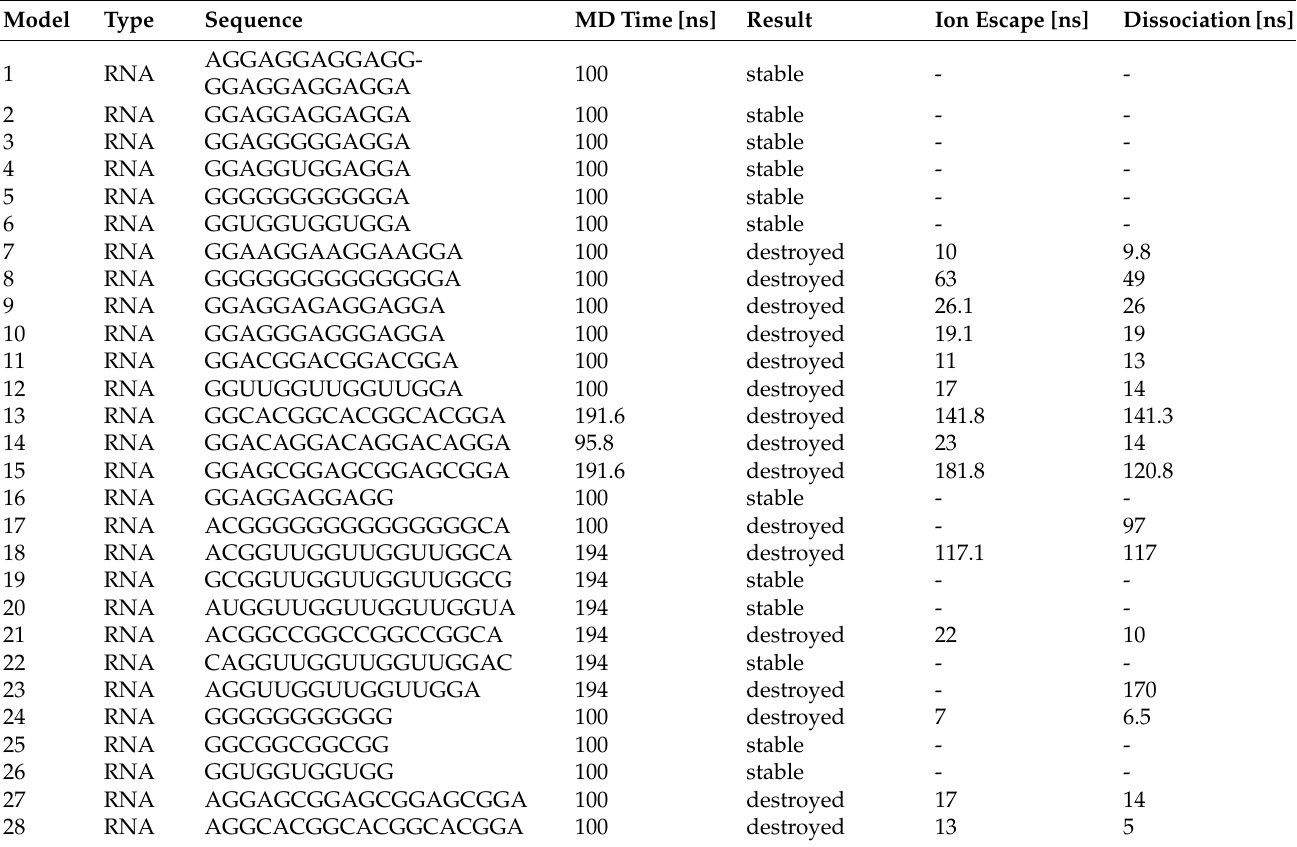
Table A1. RNA quadruplex-forming systems simulated with the Amber ff99-ILDN-Bsc0 force field. Items with dash (“-”) symbol in the sequence field represent dimerized